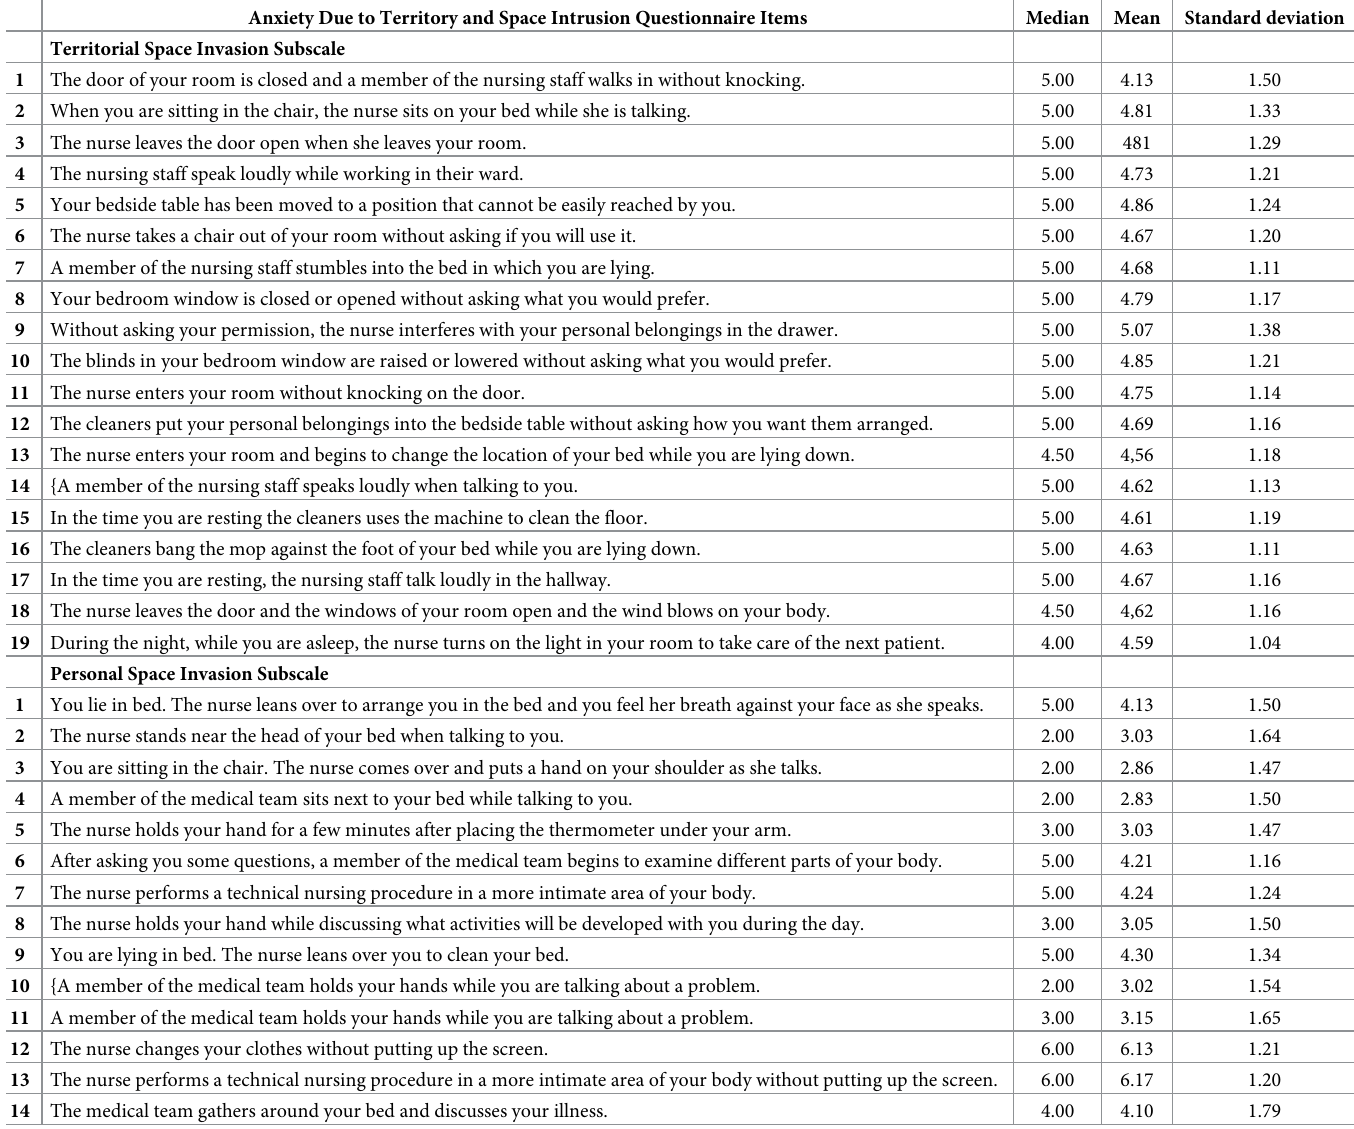
Table 3. Situations in which patients reported invasion of their territorial and personal space, according to the Anxiety Due to Territory and Space Intrusion Questionnaire. Anxiety Due to Territory and Space Intrusion Questionnaire